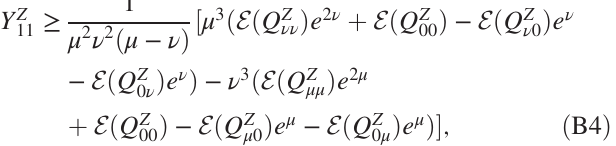
TABLE I. M ZZ consists of nine cases. M ZZ